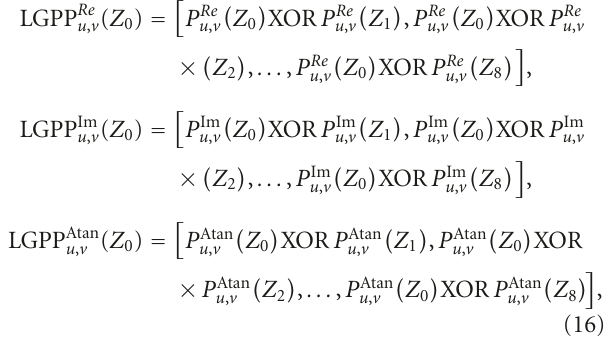
frequency v , the real-, imaginary-, and atan-LGPP value at each pixel position are formulated as: